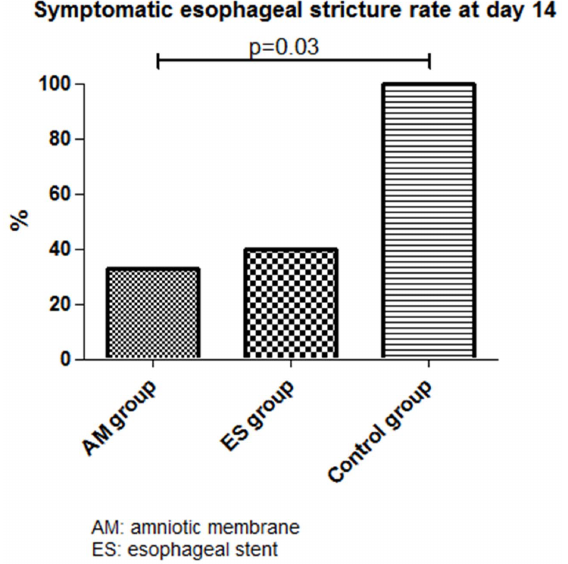
Figure 2. Symptomatic esophageal strictures rates at day 14.